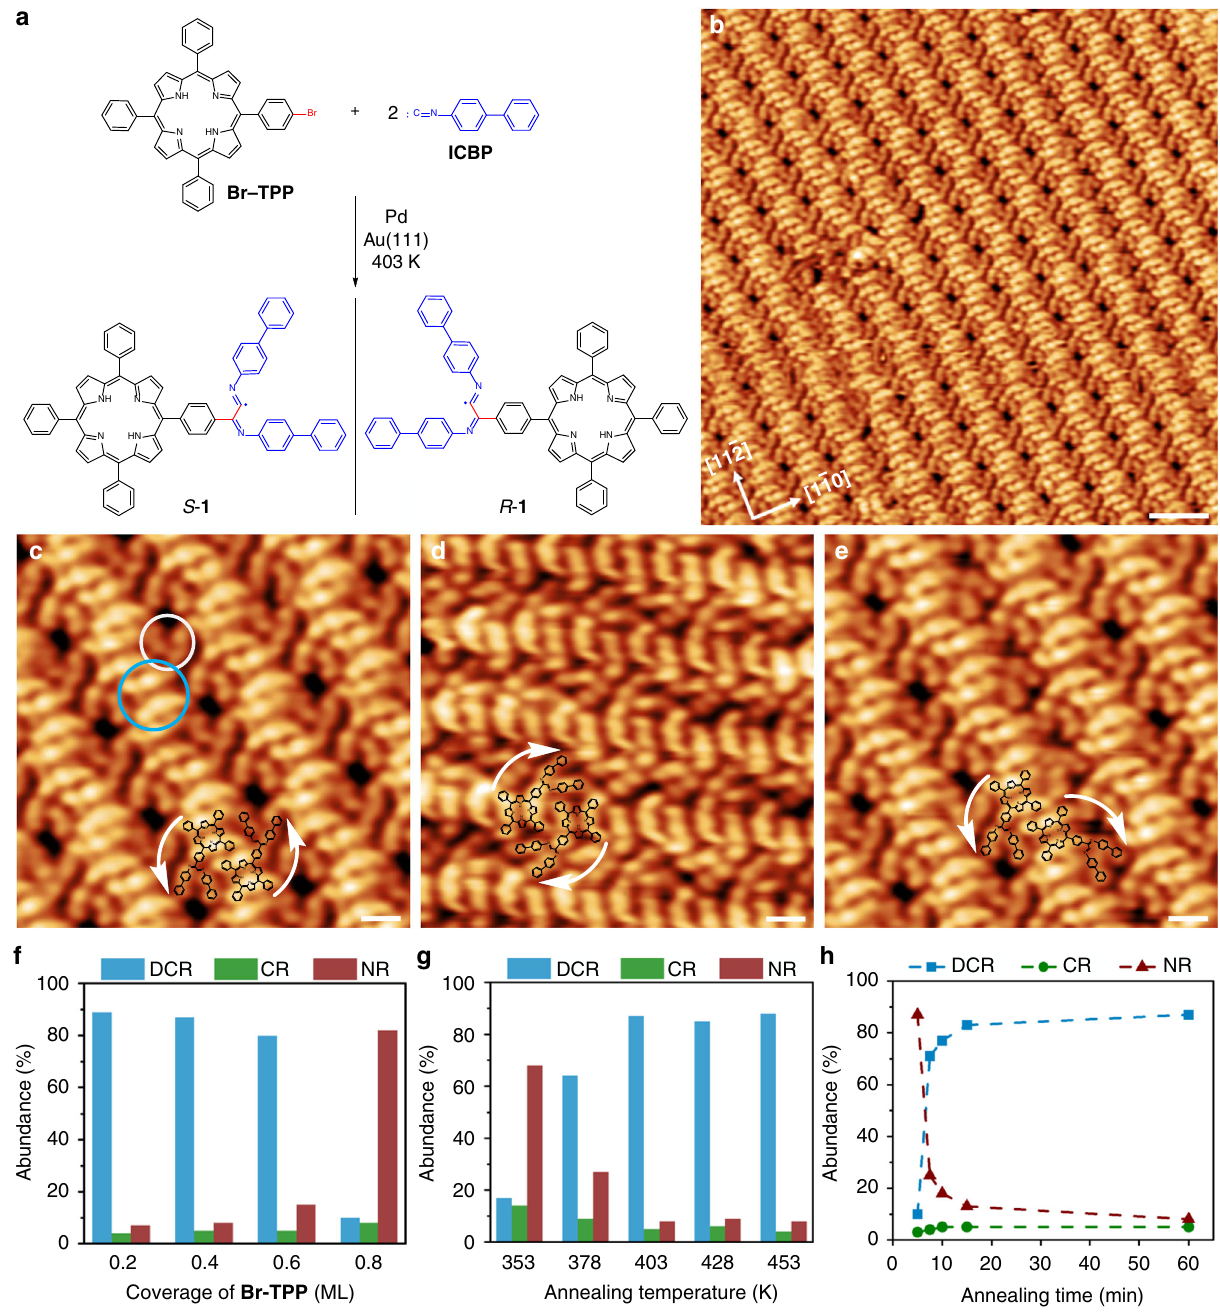
Fig. 2 DCR of one Br-TPP with two ICBP on Au(111). a DCR used to generate S - 1 and R - 1 . b STM image of the product generated from DCR. c STM image of self-assembled molecules of S - 1 . d STM image of self-assembled molecules of R - 1 . e STM image of mixed molecules of S - 1 and R - 1 . f – h Statistical analysis for the DCR of Br-TPP with ICBP at different coverages of Br-TPP ( f , reaction conditions: 403 K, 1 h), different annealing temperatures ( g , reaction conditions: ~0.4 ML Br-TPP , 1 h), and different annealing time ( h , reaction conditions: ~0.4 ML Br-TPP , 403 K). DCR: the reaction of one Br-TPP with two ICBP . CR: the reaction of one Br-TPP with one ICBP . NR: no coupling reaction. Scale bars: b 3 nm. c – e 1 nm. Tunneling parameters: b , c , e I = − 0.49 nA, U = − 1.72 V. d I = − 0.66, U = − 1.78